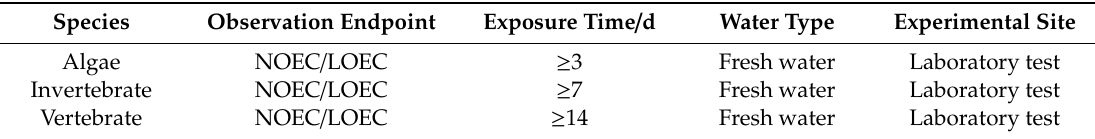
Table 3. Screening conditions of chronic toxicological